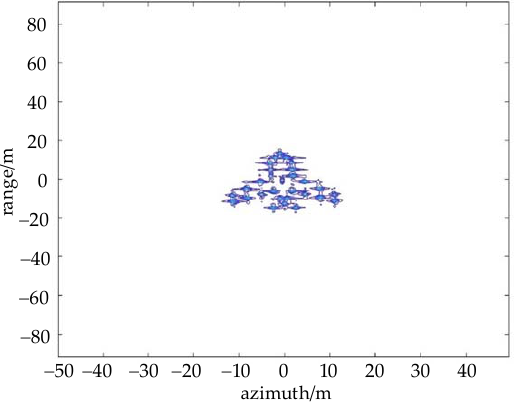
Figure 4. The ISAR image without ISRJ. Table 2. Jamming simulation